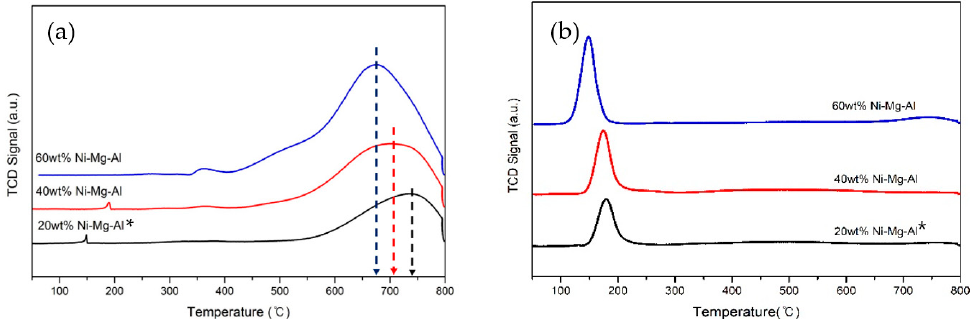
Figure 11. H 2 -TPR profiles of ( a ) fresh and ( b ) spent catalysts (* reference [41] was cited). The Ni dispersion, particle size, and turnover frequency (TOF) of the 20, 40, and 60 wt% Ni-Mg-Al catalysts at 250 ◦ C measured through H 2 -chemisorption analysis are presented in Table 3. As the Ni content increases, the Ni dispersion increased slightly and